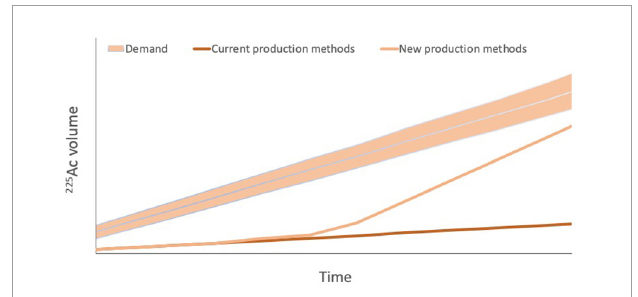
FIGURE6 Projected 225 Ac demand versus current 225 Ac production via 229